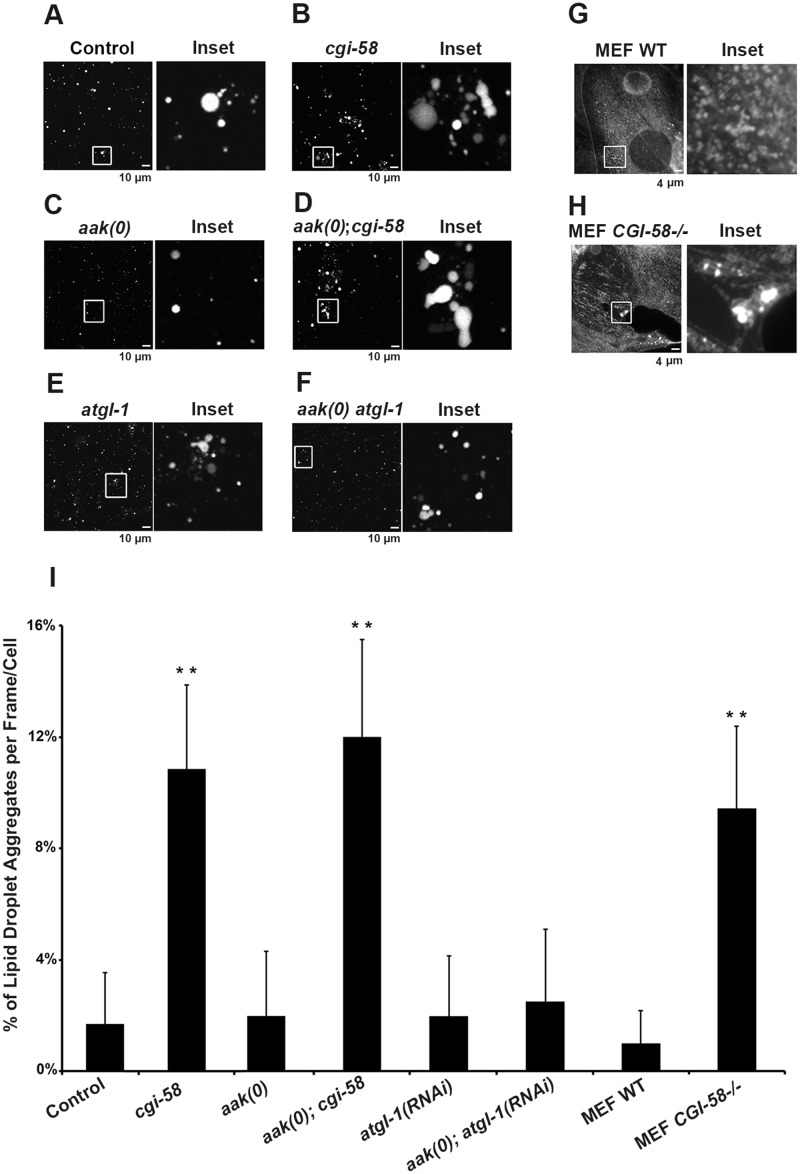
Increased lipid droplet aggregates were observed in CGI-58-deficient Dauers.
(A)-(F)
cgi-58, but not atgl-1, limits the formation of lipid droplet aggregates in both control and AMPK mutant dauer larvae. Dauer larvae were stained with C1-BODIPY-C12 32 hours after being shifted to 25°C. Lipid droplets were subsequently isolated from the stained dauer larvae. Scale bar = 10 μm. All strains carry daf-2(e1370) in (A)-(F) and (I). (G)-(H)
CGI-58 limits the formation of lipid droplet aggregates in MEFs. MEFs were stained with C1-BODIPY-C12 and imaged using a 100x objective. Scale bar = 4 μm. (I) Quantification of the percentage of lipid droplet aggregates per frame (for dauer larvae) or per cell (for MEFs) described in (A)-(H) determined for 1000 lipid droplets/100 cells analyzed for each respective genotype. Lipid droplets with a volume greater than 20 μm3 are considered as aggregates. ** indicates statistical significance (P<0.01) to all other columns.